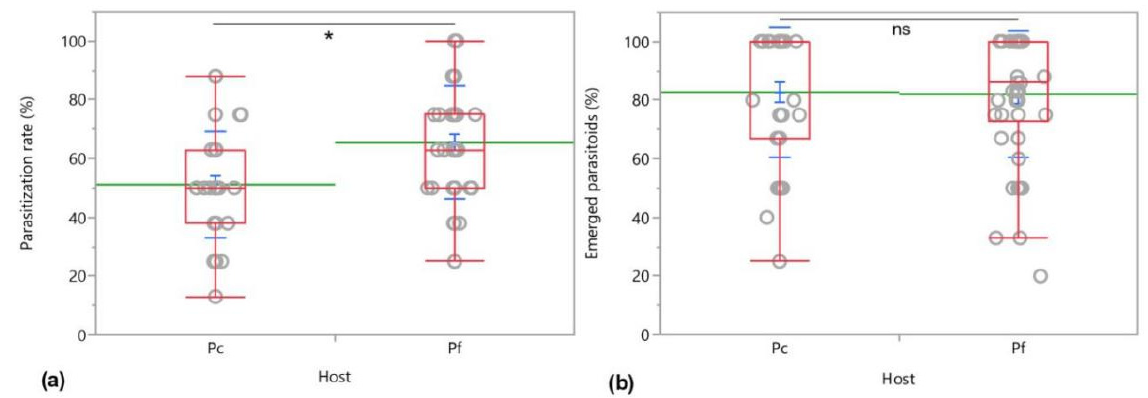
Figure 6. Parasitization ( a ) and emergence rates (%) ( b ) of Anagyrus vladimiri on Pseudococcus comstocki (Pc) and Planococcus ficus (Pf) in no-choice tests. Parasitization rate were analyzed with Wilcoxon test ( p < 0.05) while emerged parasitoids with Kruskal–Wallis test ( p < 0.05). The asterisk indicates significant difference between parasitoids emerged from the two hosts, ns = not significant.